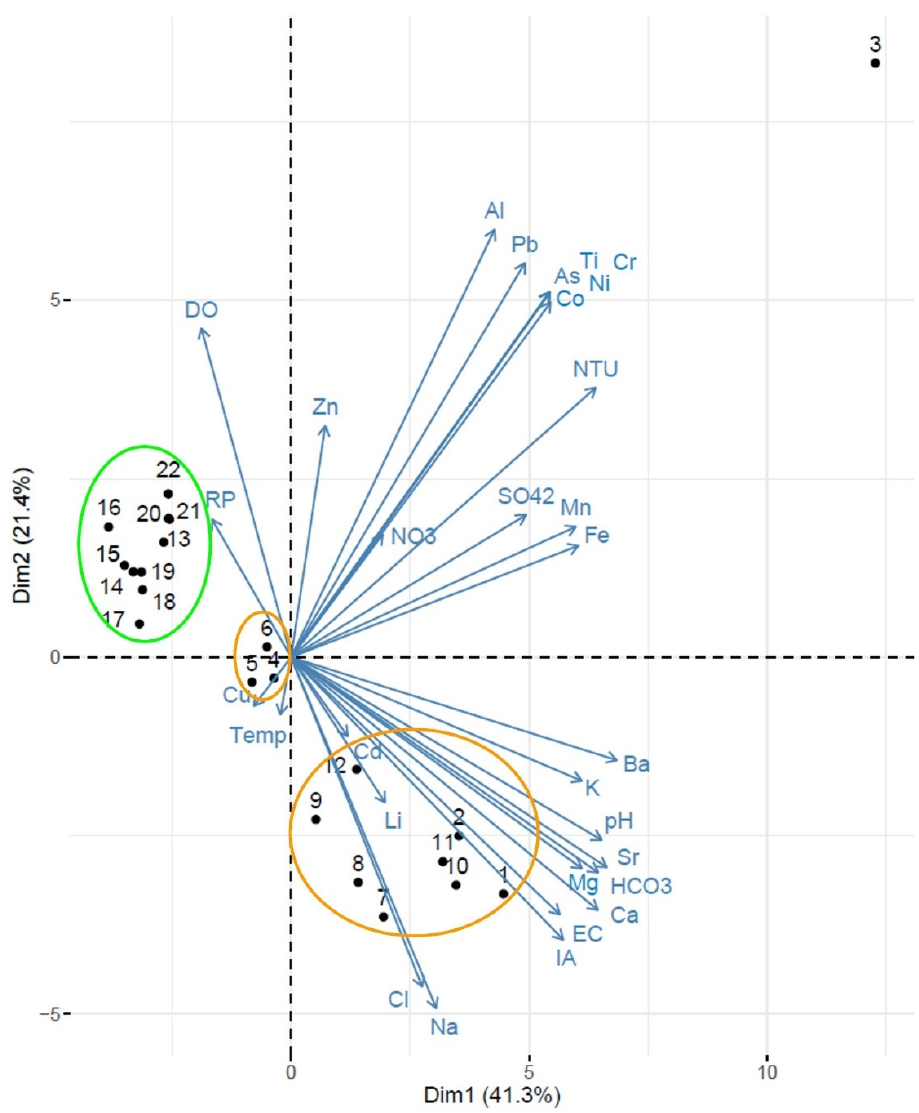
Figure 4. Principal Components Analysis (PCA) of water quality parameters and impervious area from four urban (outlined in orange) and four naturally vegetated (outlined in green) Temperate Highland Peat Swamps on Sandstone (THPSS) from April–June 2018 (excluding Mount Hay). Sites are numbered as urban Bullaburra (1–3), Wentworth Falls (4–6), North Lawson (7–9), and Popes Glen (10–12), and naturally vegetated Mount Hay (13), Hat Hill (14–16), Lawson (17–19), and Kings Tableland (20–22). Variables are indicated as impervious area (IA), pH, electrical conductivity (EC), dissolved oxygen (DO), temperature (Temp), turbidity (NTU), nitrates (NO3), reactive phosphates (RP), calcium (Ca), bicarbonate alkalinity as CaCO 3 (referred to as HCO3), magnesium (Mg), potas- sium (K), aluminium (Al), strontium (Sr), barium (Ba), iron (Fe), manganese (Mn), sulfate (SO42), cobalt (Co), arsenic (As), nickel (Ni), chromium (Cr), titanium (Ti), lead (Pb), zinc (Zn), copper (Cu), cadmium (Cd) and lithium (Li).